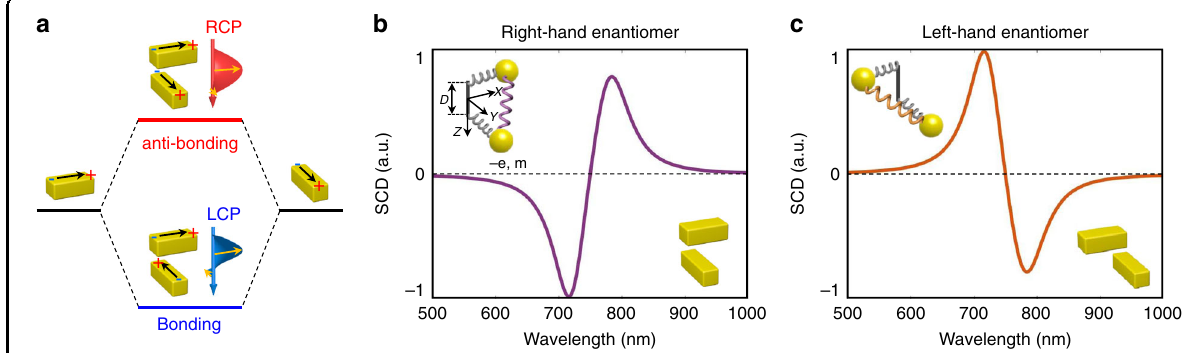
Figure 1e and f are the SCD spectra (green solid line) of a nanorod pair and its enantiomer, respectively. The SCD